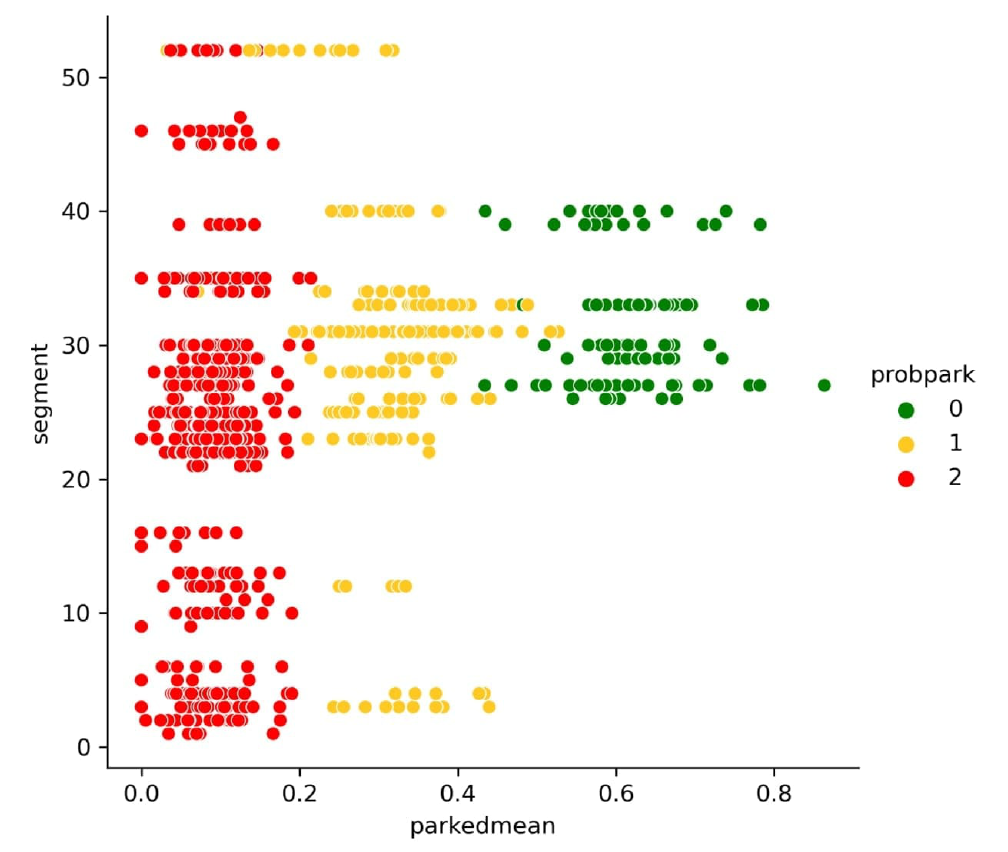
Figure 5. Probability of the feature parkedmean to happen, in each segment, related to the three levels of availability.